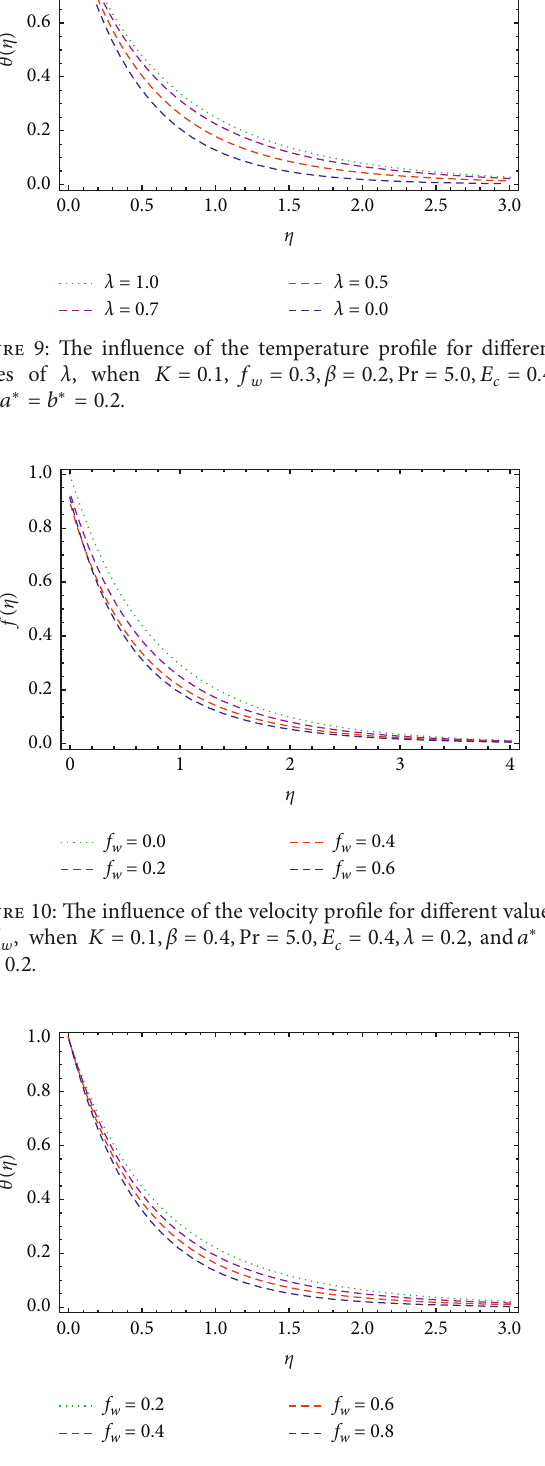
Figure 11: The influence of the temperature profile for different values of f w , when K � 0 . 1 , β � 0 . 4 , Pr � 5 . 0 , E c � 0 . 4 , λ � 0 . 2 , and a ∗ � b ∗ � 0 . 2 .